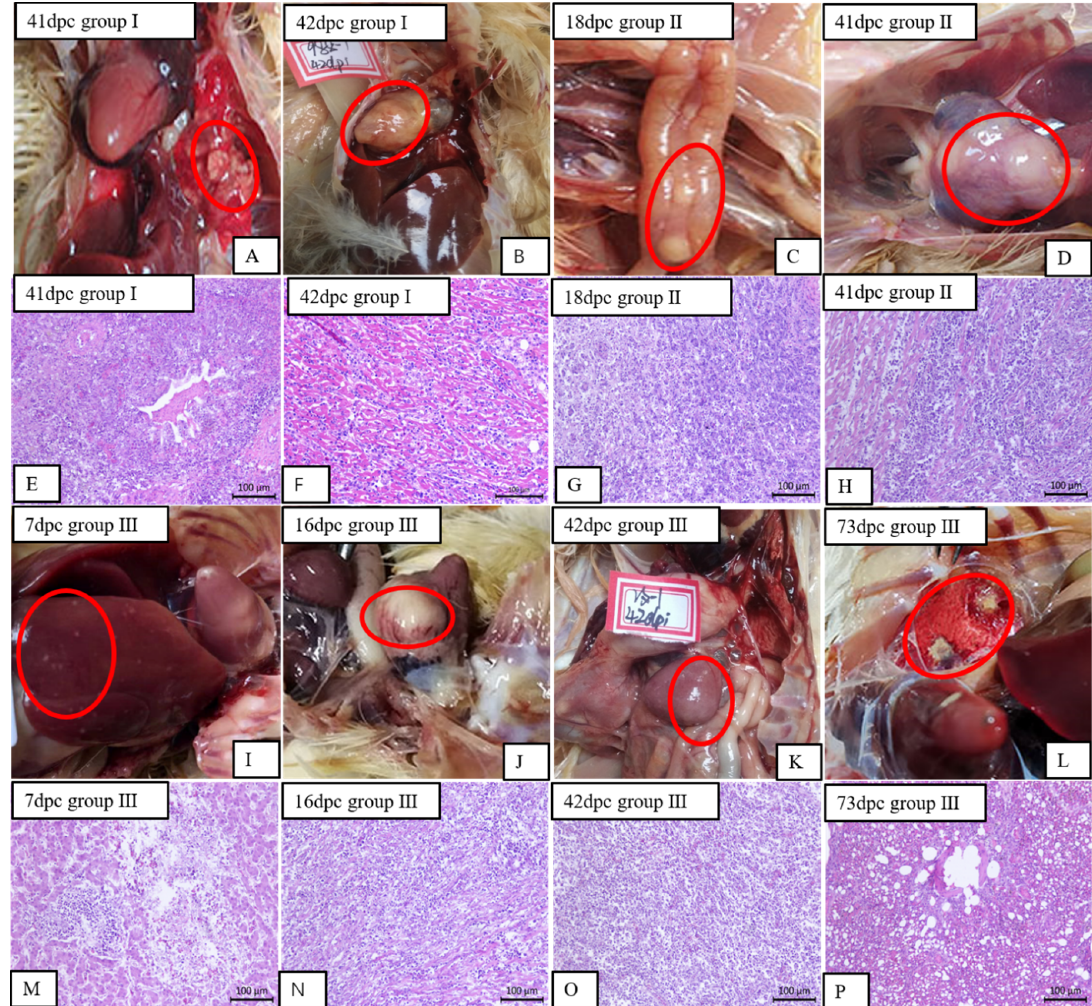
Figure 6. Anatomical and histological lesions: ( A , L ) white solid nodules in the lungs; ( E , P ) numerous proliferating tumor cells concentrated in the lung tissue; ( B , D , J ) tumor or tumor-like lesions in the heart; ( F , H , N ) numerous infiltrations of di ff use lymphocytosis in myocardial fibers; ( C ) pancreas hemorrhage with tumor; ( G ) numerous lymphocytosis proliferations in pancreas; ( I ) white tumor nodules, approximately 1–3 mm in diameter, on the liver surface; ( M ) numerous proliferating tumor cells were concentrated in the hepatic tissue; ( K ) white tumor nodule on the surface of spleen; ( O ) large number of lymphocytes infiltrated in the spleen tissue.